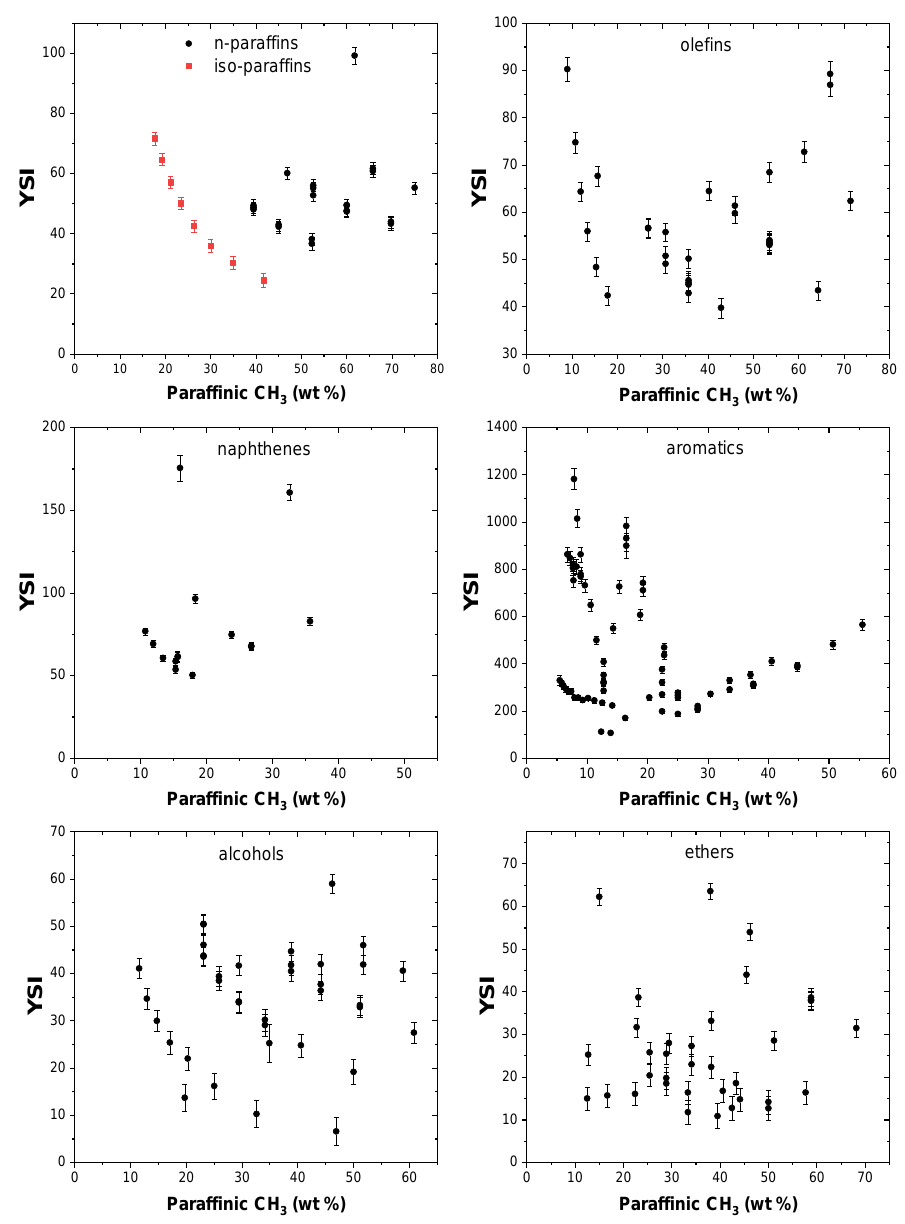
Figure 3. Effect of paraffinic CH 3 groups on YSI .